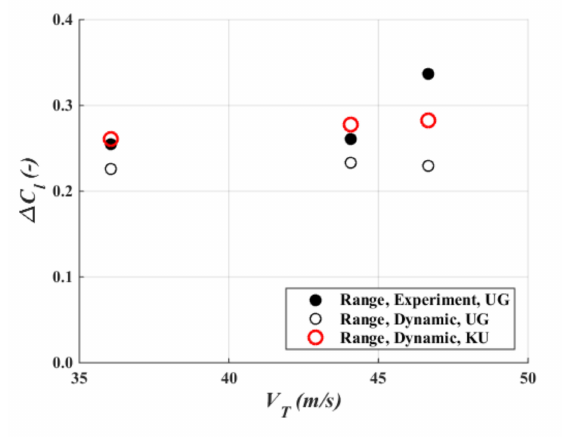
Figure 9. Range of deviations in the lift coe ffi cient at η B = 75%, C d =